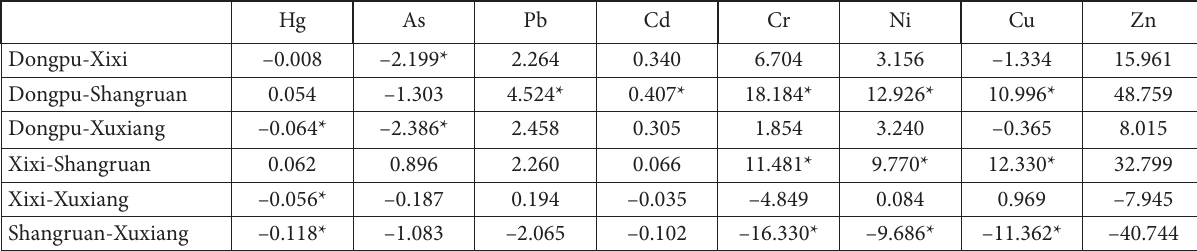
Table 5. Significance tests of soil heavy metal concentrations in representative areas